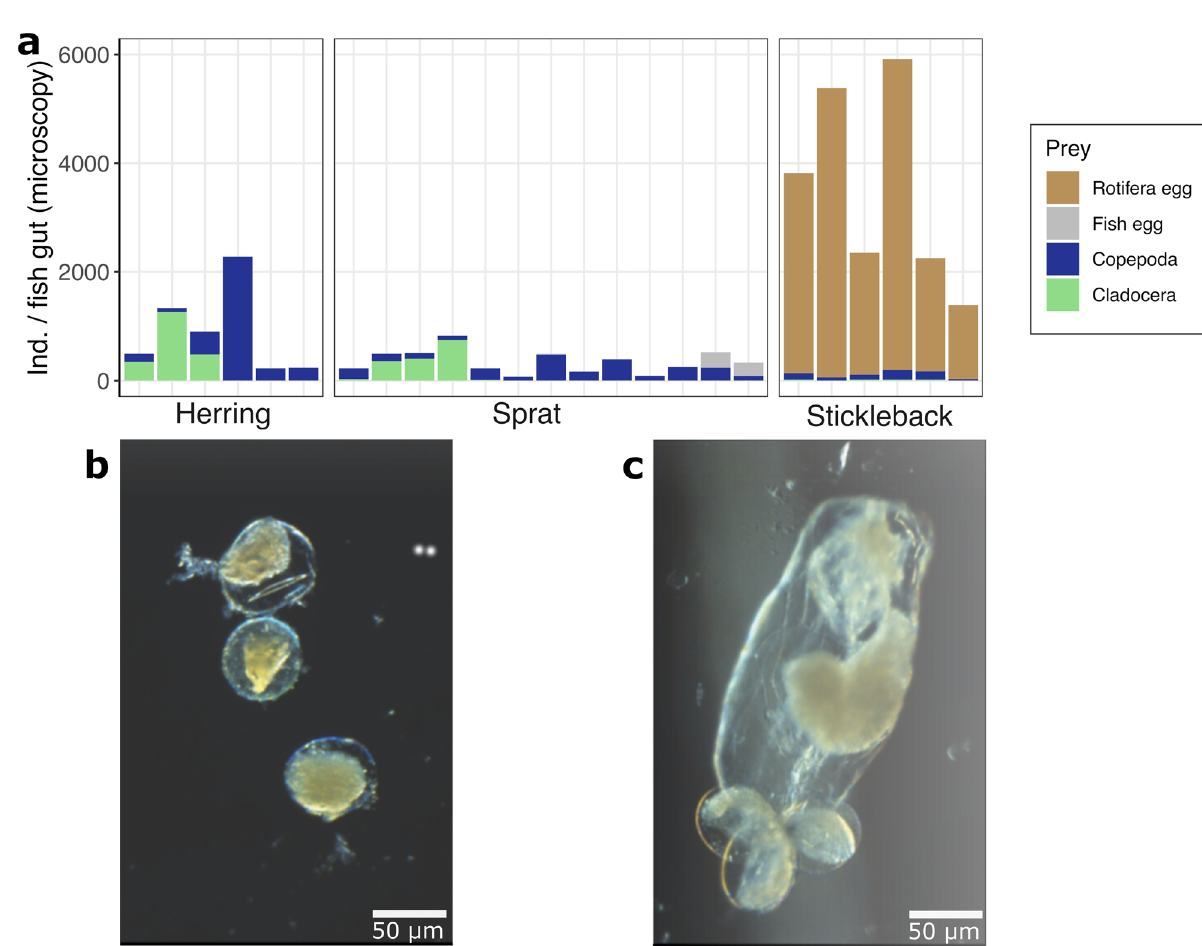
Figure 4. ( a ) Microscopic count of gut content of the planktivorous fish. Rotifers were identified as rotifer eggs. ( b ) Eggs were observed in the gut content of stickleback, originating from the rotifer genus Synchaeta . ( c ) Female of the rotifer genus Synchaeta carrying three eggs as identified from water samples. Scales are the same for ( b ) and ( c